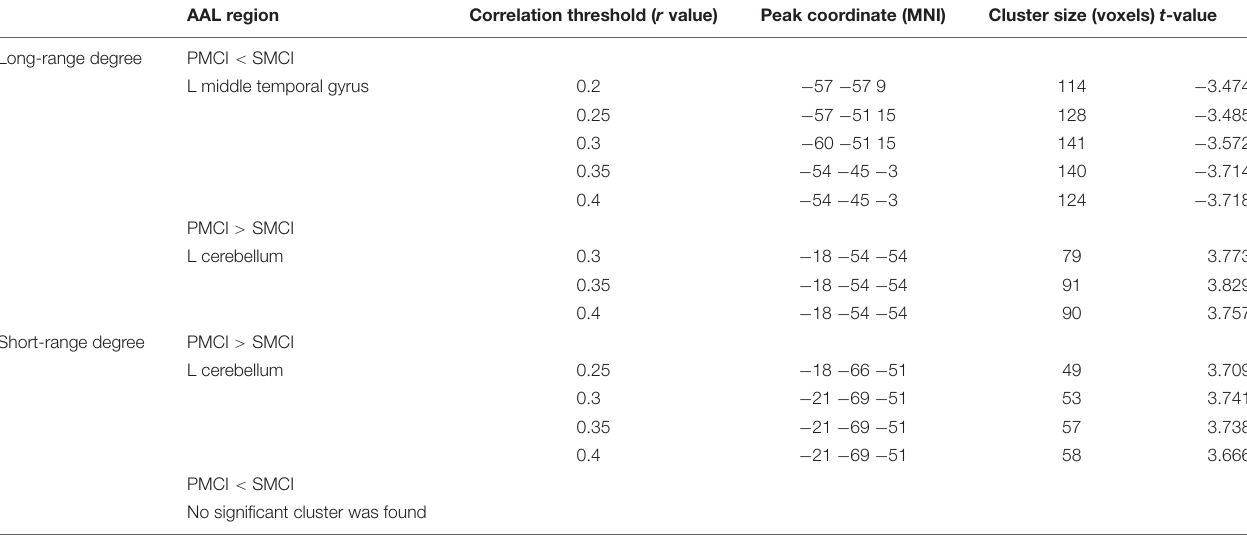
TABLE 4 | Cross-sectional degree comparison between PMCI and SMCI groups. AAL region Correlation threshold ( r value) Peak coordinate (MNI) Cluster size (voxels) t -value